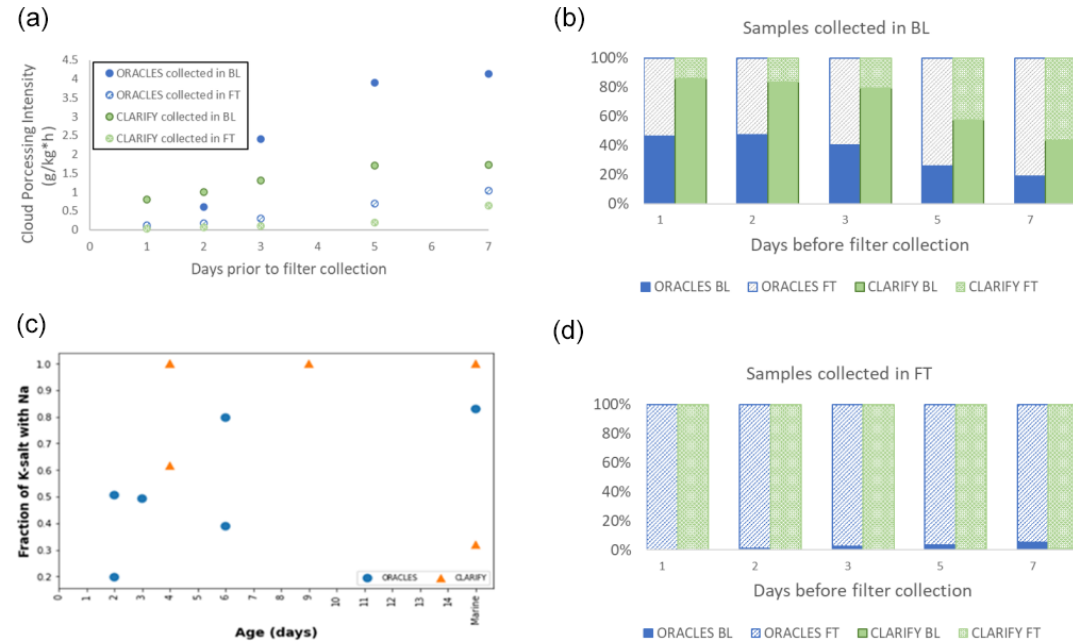
Figure 7. (a) BL and FT ORACLES and CLARIFY cloud processing intensity. (b) Time spent in BL and FT for samples collected in the BL in the days prior to filter collection. (c) Fraction of K salt, per filter, mixed with Na. (d) Fractional time spent in BL and FT for samples collected in the FT in the days prior to filter